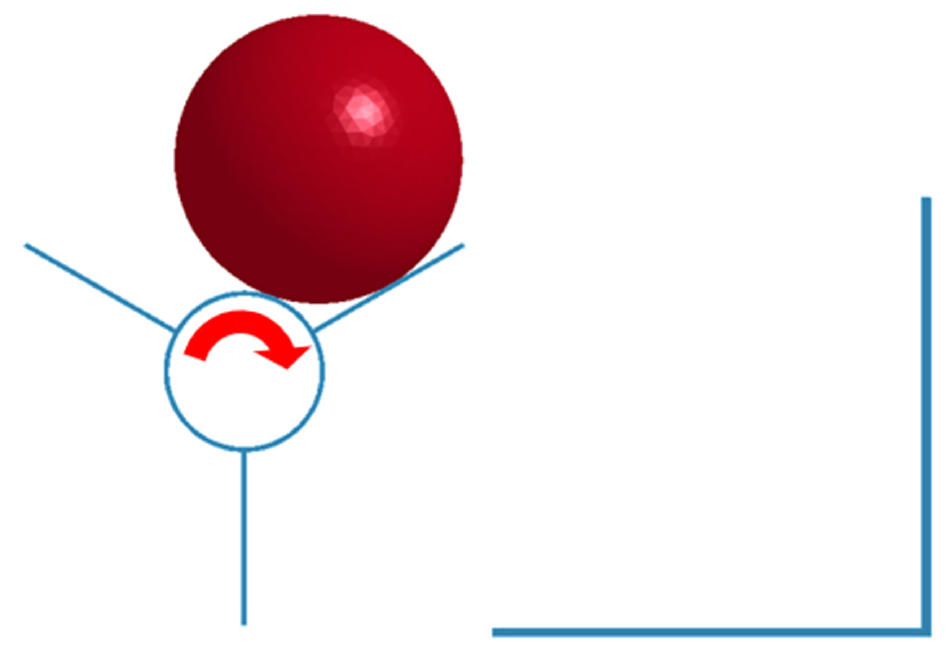
Figure 8. Condition 3 in the simulation environment.